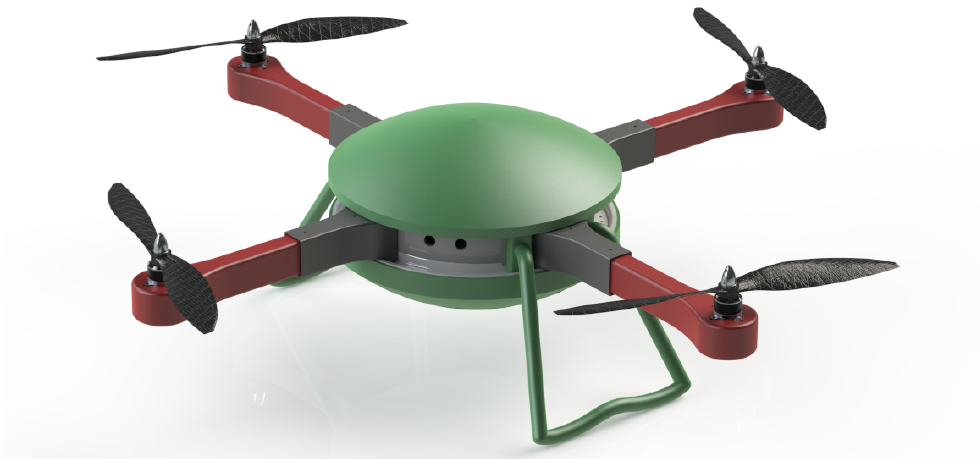
Figure 1. Graphic rendering of the PoliDrone UAV in the S4A-C configuration: four arms with a single motor/propeller each.